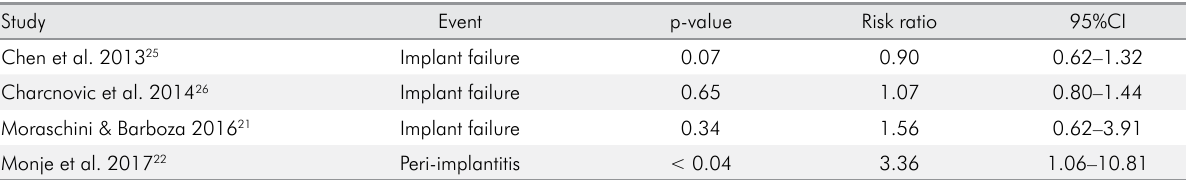
Table 3. Results of the meta-analysis for the events “implant failure” and “peri-implantitis”, reported by the four reviews that performed quantitative analysis.